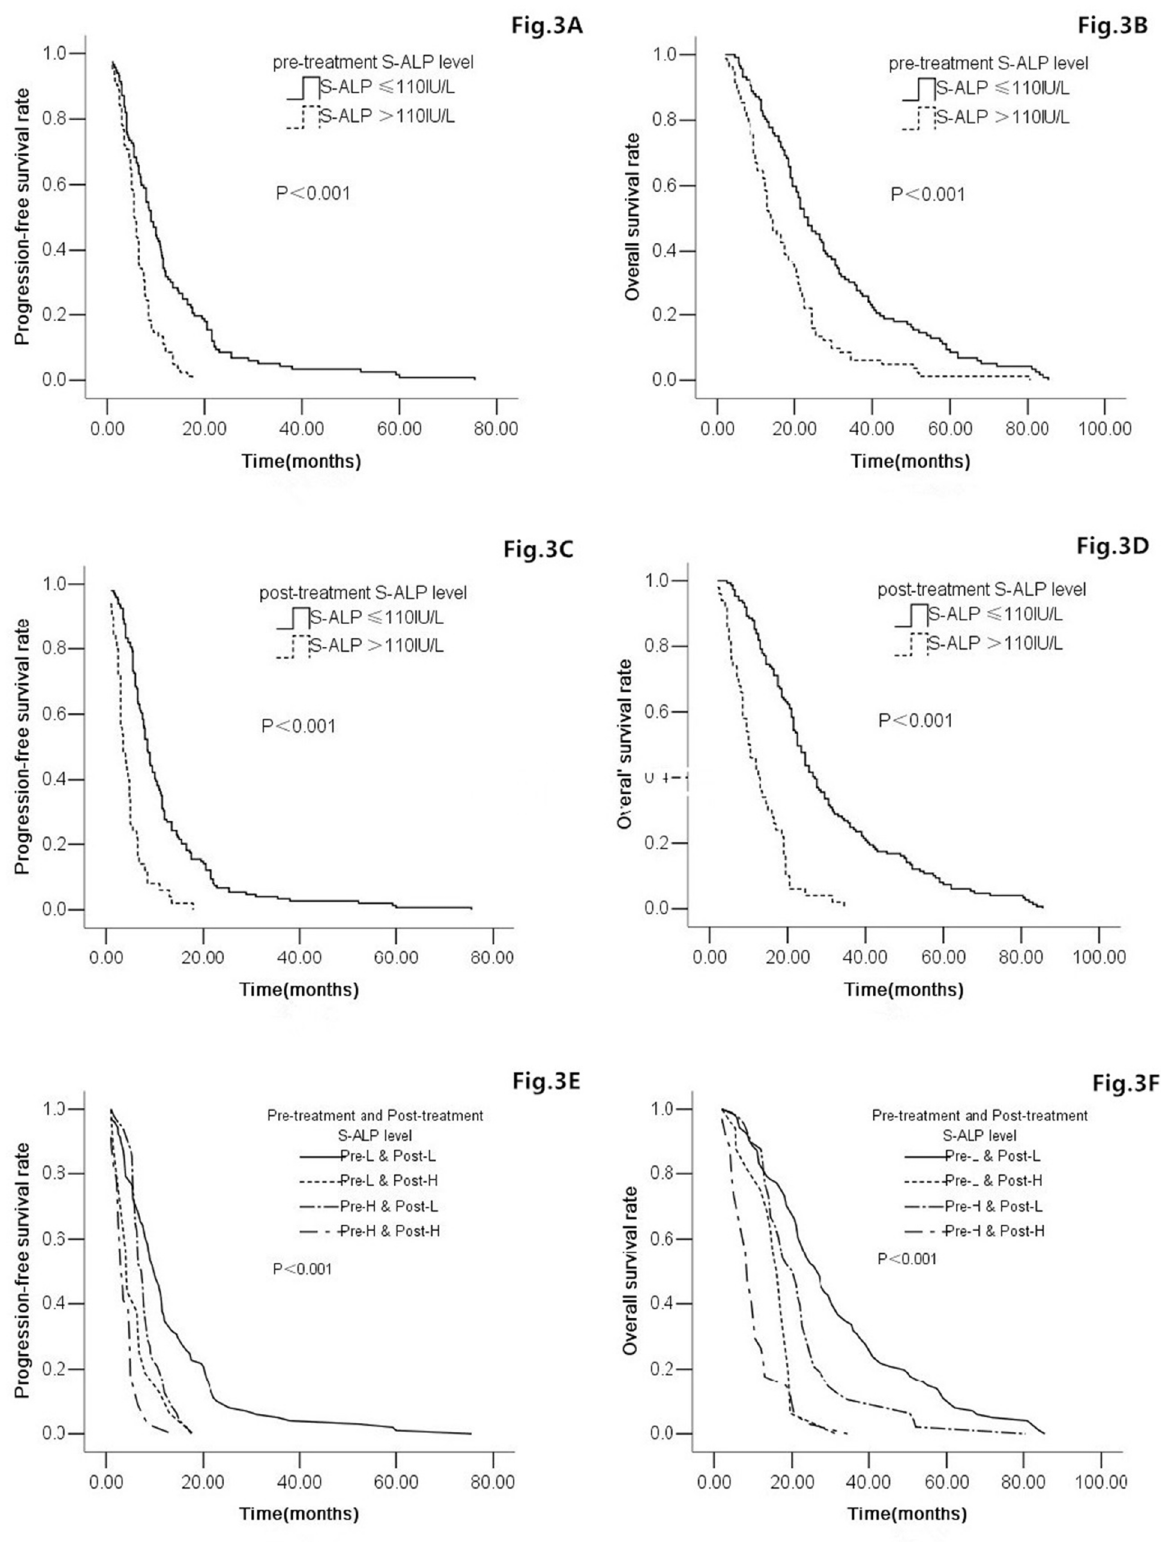
Figure 3 - Kaplan-Meier survival curves are shown for the 199 patients with only bony involvement according to the pre-treatment (and post-treatment) S-ALP level. A) PFS according to the pre-treatment S-ALP ( P o 0.001). B) OS according to the pre-treatment S-ALP ( P o 0.001). C) PFS according to the post-treatment S-ALP ( P o 0.001). D) OS according to the post-treatment S-ALP ( P o 0.001). E) PFS according to the combination of pre-treatment and post-treatment S-ALP ( P o 0.001). F) OS according to the combination of pre-treatment and post-treatment S-ALP ( P o